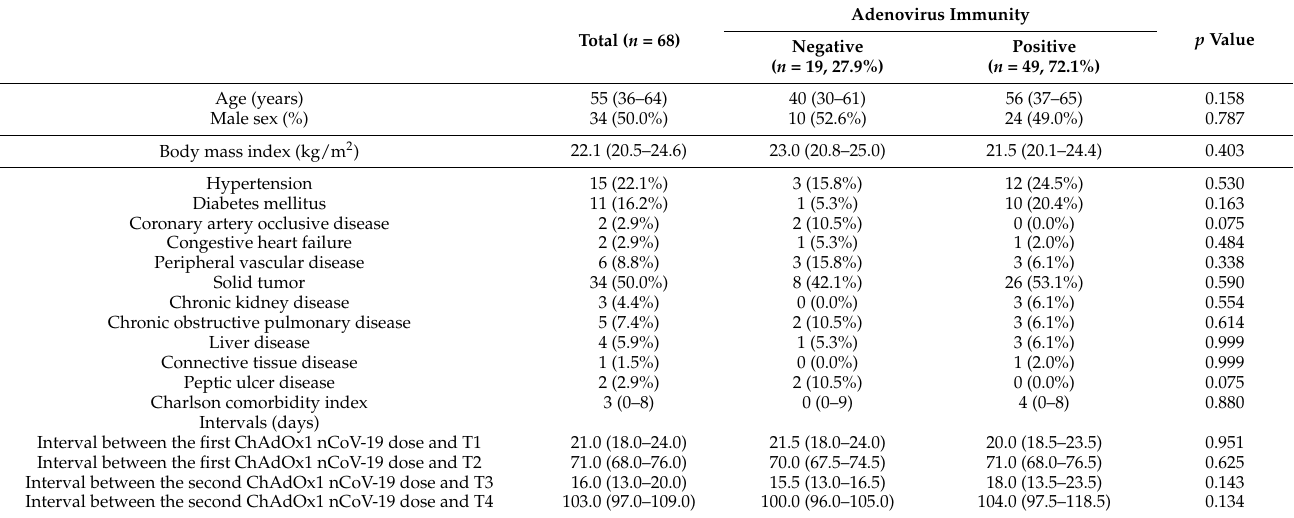
Table 1. Baseline characteristics of individuals with ChAdOx1 nCoV-19 vaccination according to pre-existing adenovirus